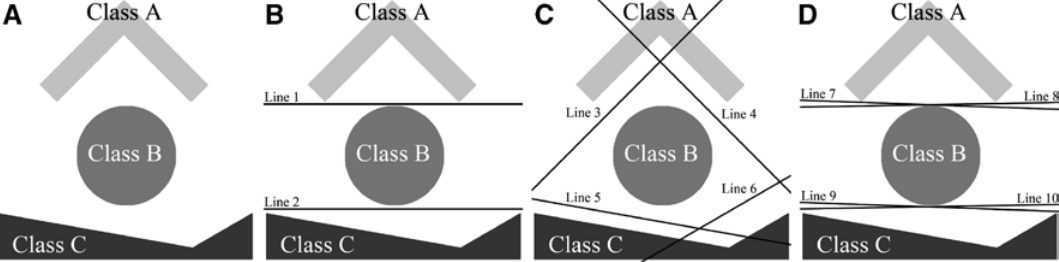
Figure 1: A comparison among possible classifications: (A) A two-dimensional three-class problem. (B) Possible classification with a two-layer perceptron with two hidden neurons. (C) Possible classification with a two-layer perceptron with four hidden neurons. (D) Typical result of four-hidden-neuron network trained by a variation of back-propagation algorithm